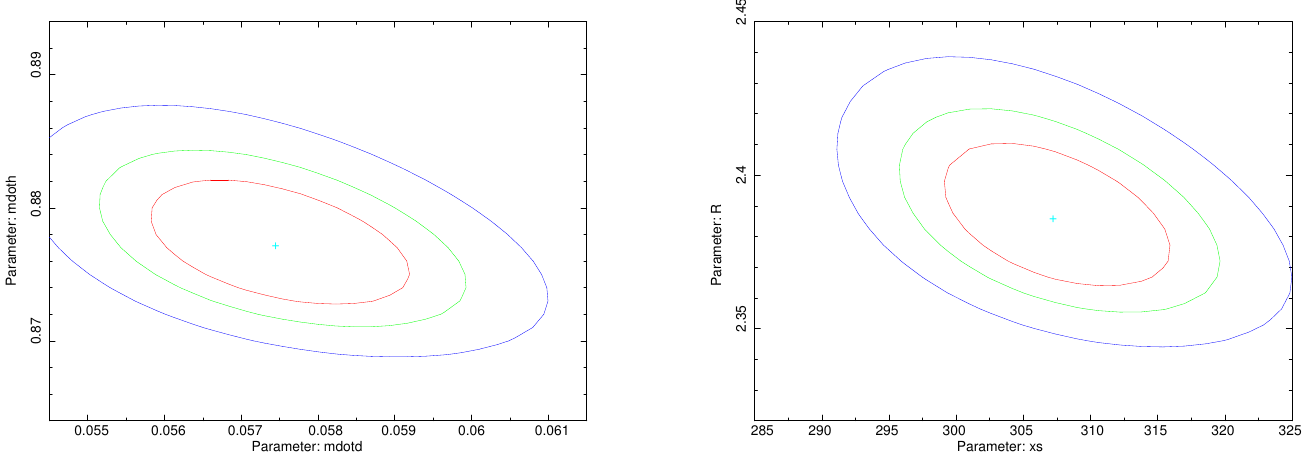
Figure 2. 2D confidence contour plot for MJD 57,188.77, for ˙ m R in the right panel. − −